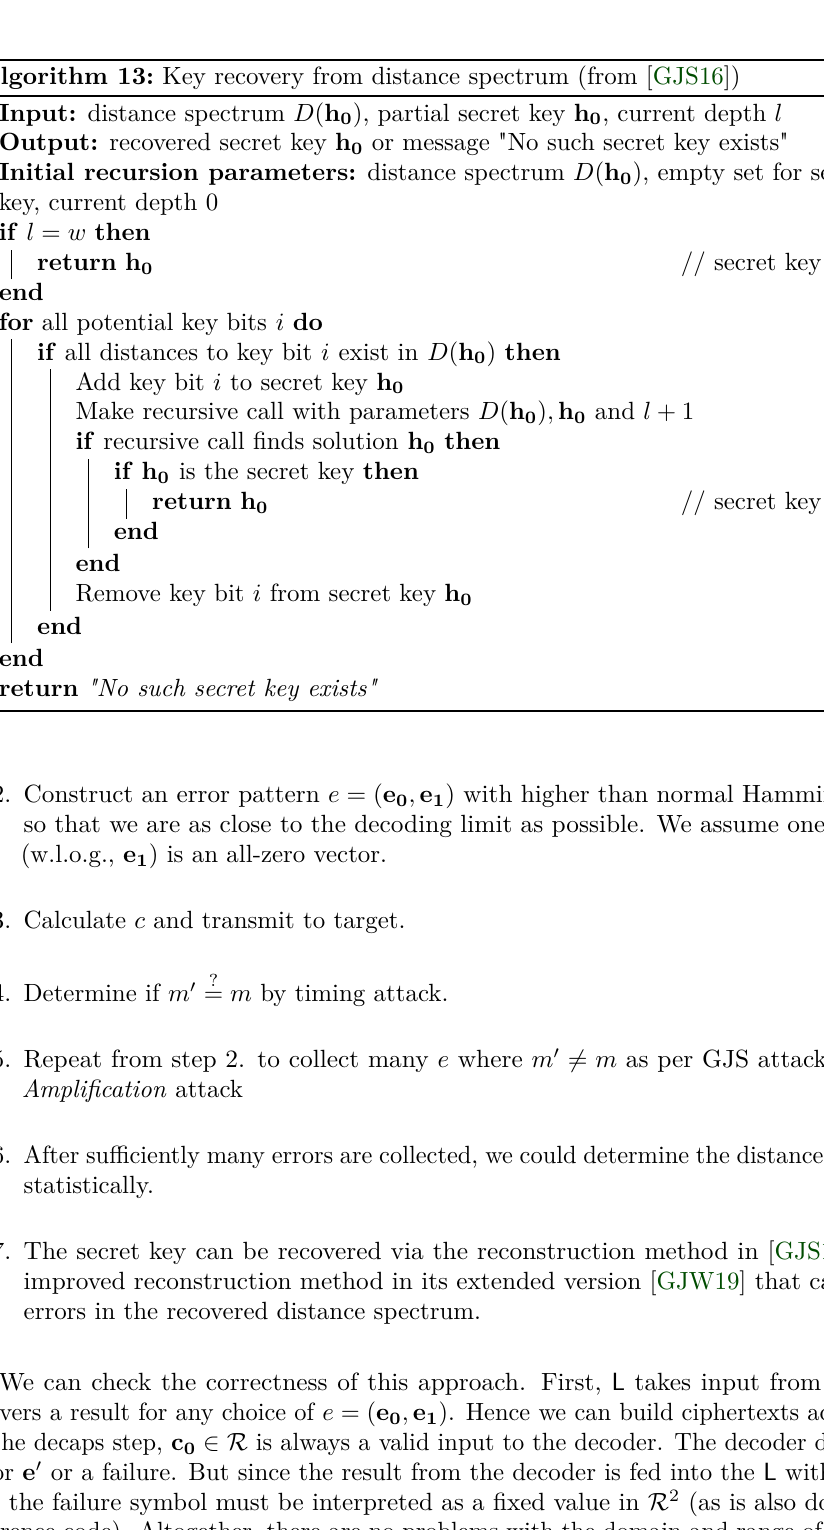
Key-Recovery Timing Attacks Due to Rejection-Sampling in HQC and BIKE